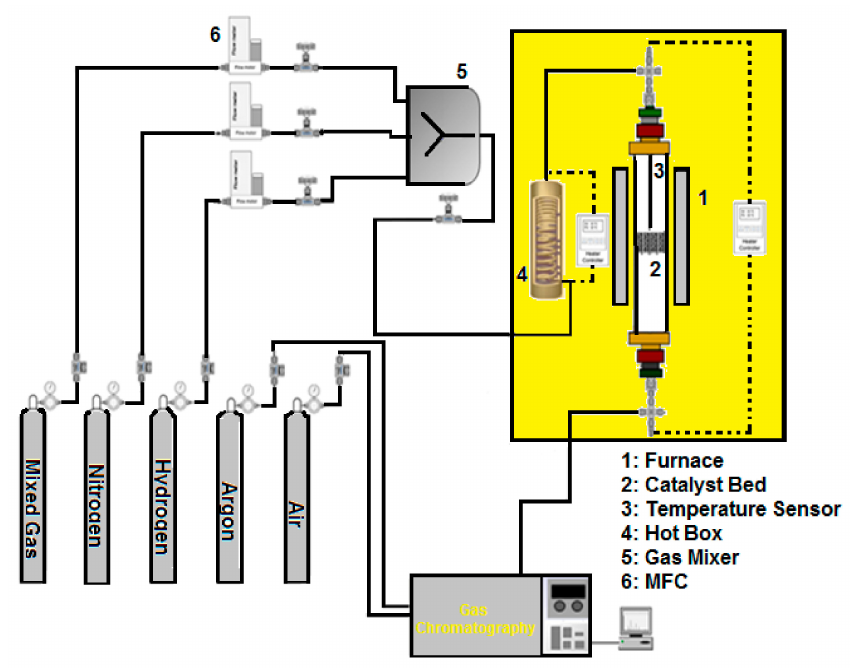
Figure 15. Schematic flow diagram of the fixed-bed tubular microflow reactor. MFC: mass flow